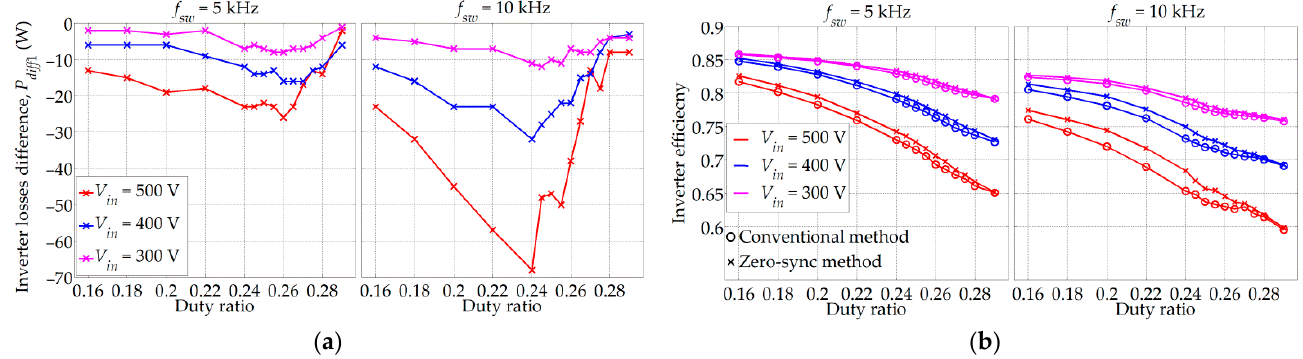
Figure 13. Inverter losses difference ( P diff 1 ) ( a ) and inverter efficiency ( b ) as a function of the duty ratio for different values of the inverter input voltage and switching frequency.